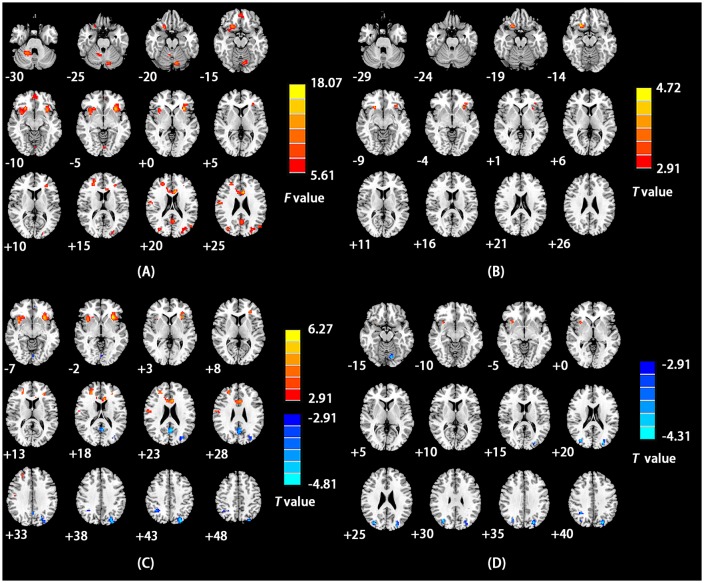
(A) Brain regions with a main effect of the group on ReHo values. The color bars signify F values. (B) Brain regions showing significant differences in ReHo values between the EO-CD and AO-CD groups. Warm indicates regions with increased ReHo in EO-CD vs. AO-CD. (C) Brain regions with significant differences in ReHo values between EO-CD patients and HCs. Warm and cool colors, respectively, indicate increased and decreased ReHo in EO-CD patients compared with HCs. (D) Brain regions with significant differences in ReHo values between AO-CD and HCs. Cool colors indicate decreased ReHo in AO-CD patients compared with HCs. For all panels, the left side of the figure corresponds to the right side of the brain.